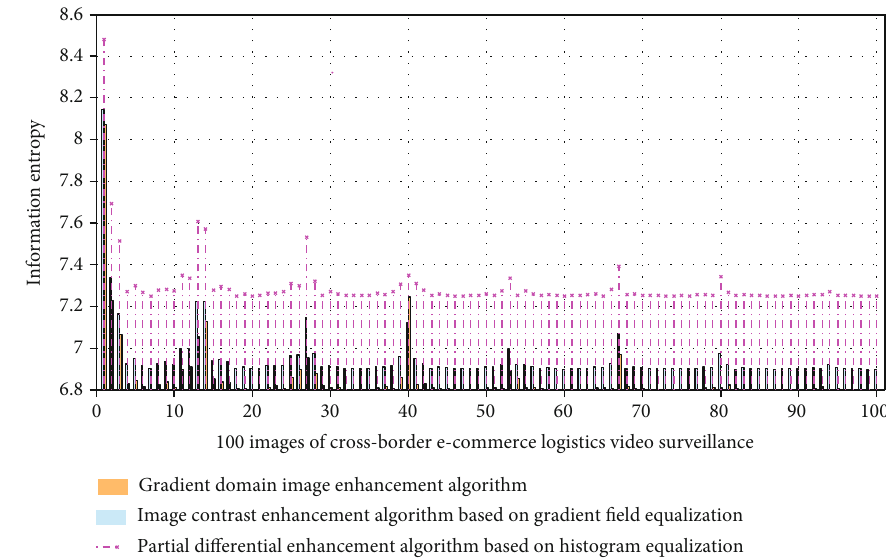
Figure 6: The information entropy of the experimental results corresponding to the three algorithms.